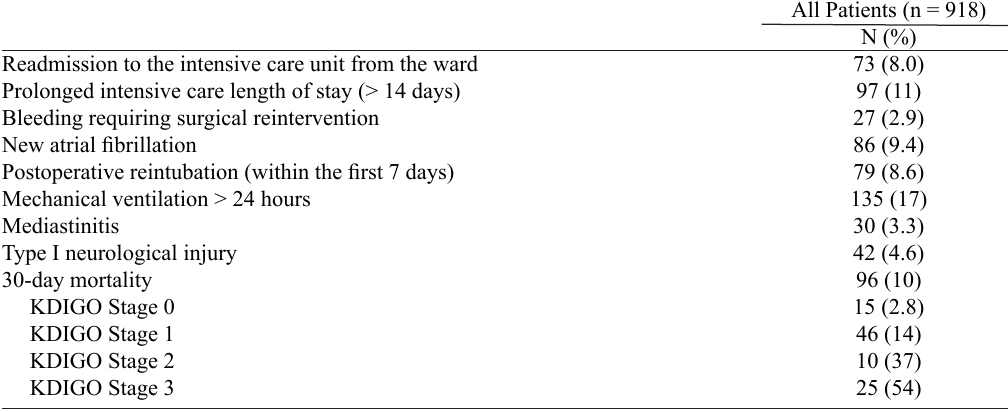
Table 4. Postoperative complications of patients who underwent cardiac surgery.